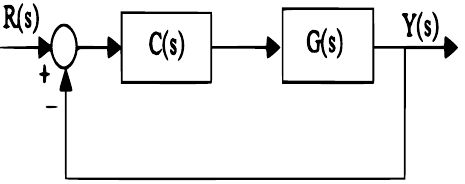
Figure 6. Feedback control system with PI controller.